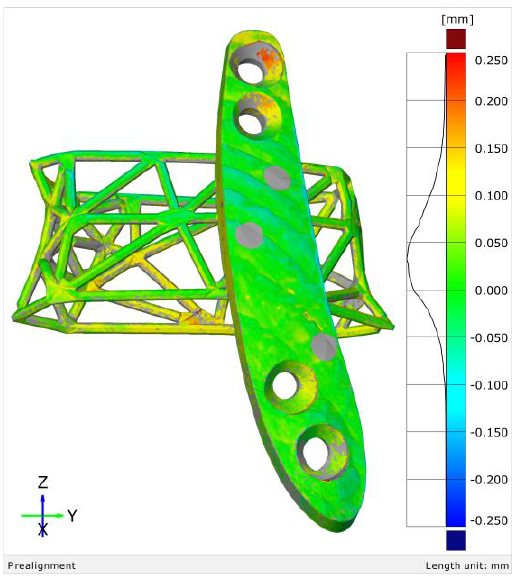
Figure 8. The additive manufacturing error of the end-use implant on the nominal CAD implant with the verified mesh size.